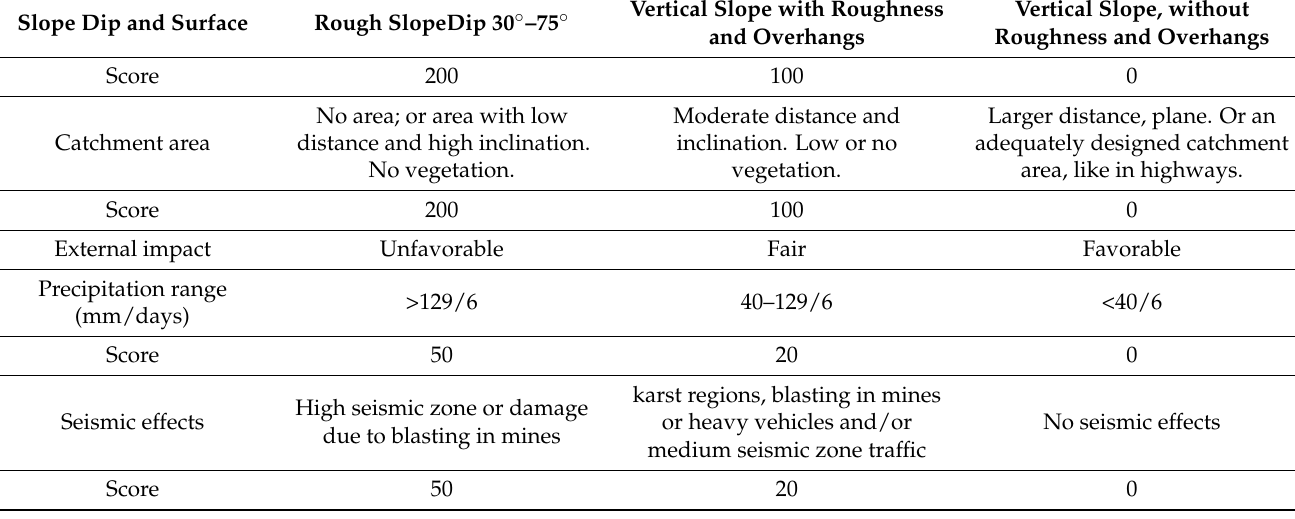
Table 3. Modified scores from